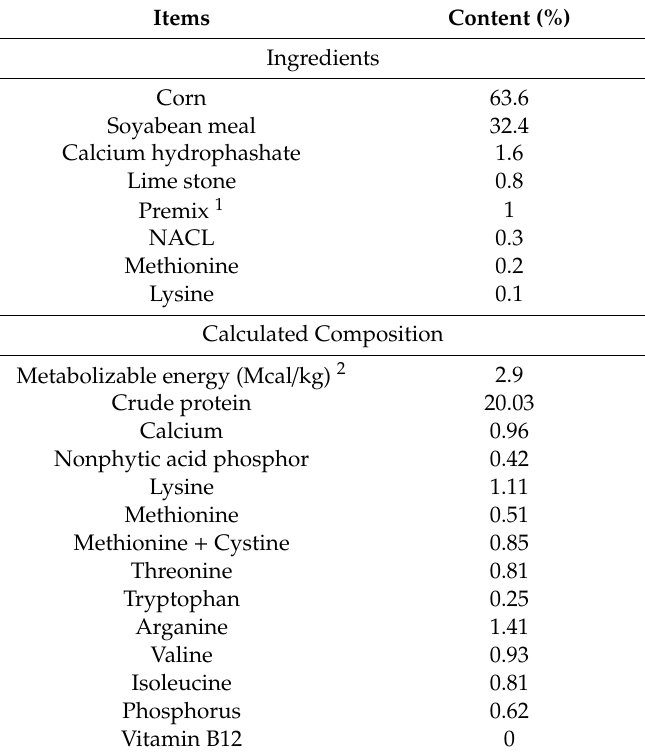
Table 1. Composition of basal diet (% as